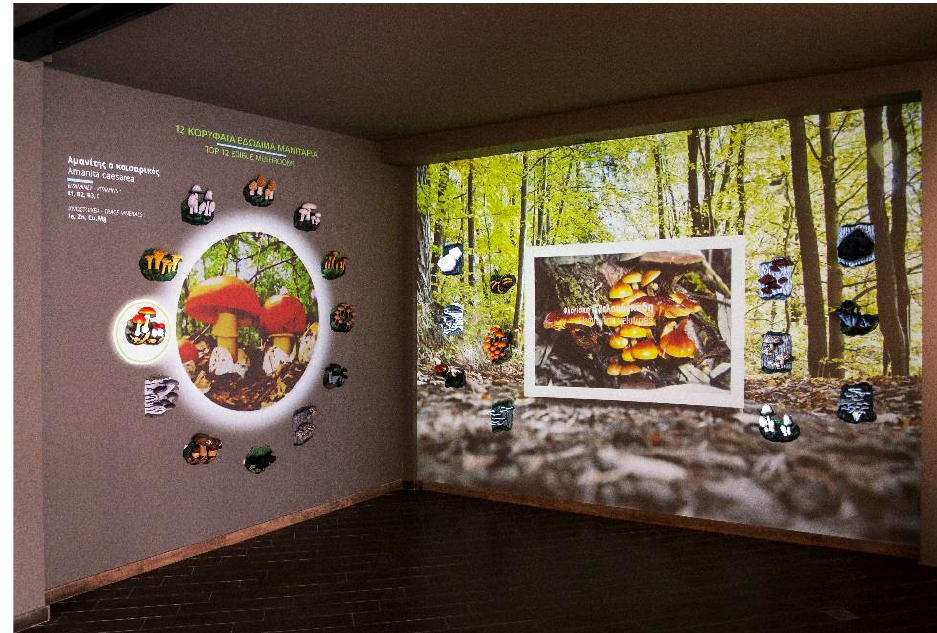
Figure 2. 12 top therapeutic mushrooms.